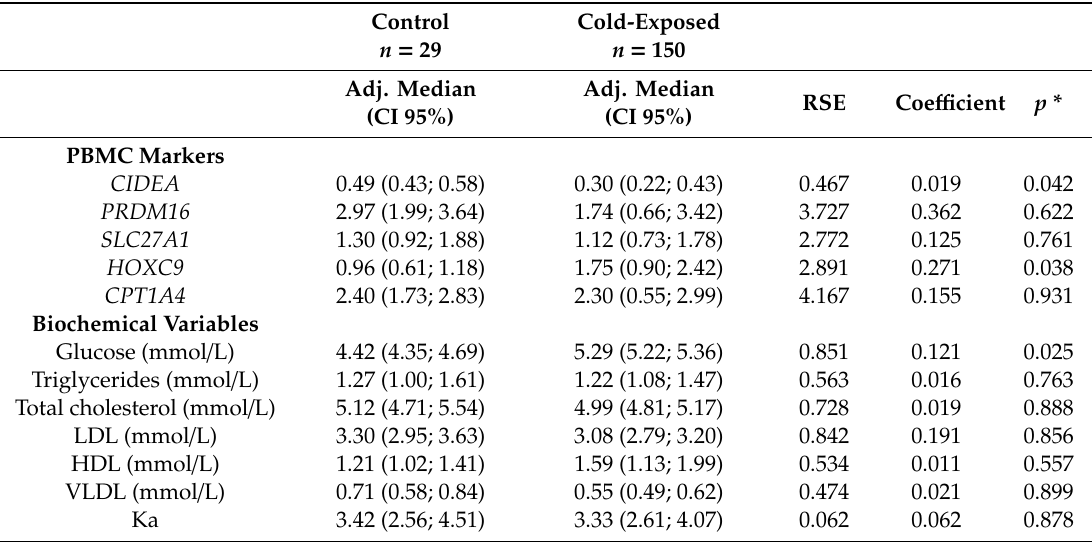
Table 3. PBMC gene expression of markers of browning, beigeing, and fatty acid utilization and biochemical variables, comparison according to cold